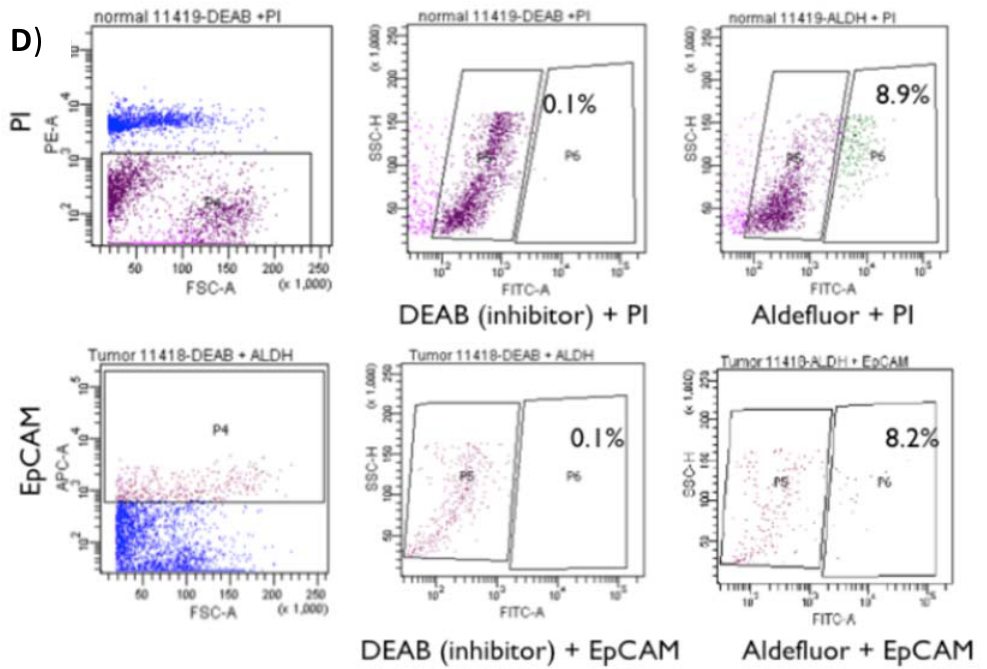
Figure 1. Identification and isolation of ALDEFLUOR-positive stem cells from fresh patient normal and tumor samples. Panels A, B—ALDH activity in the bottom of fresh normal isolated crypts. Normal isolated colonic crypts subjected to ALDEFLUOR assay in the presence ( A ) or absence of the inhibitor of ALDH activity ( B ). This image was taken using a Zeiss Epi-fluorescence microscope using the 10X objective. ( C ) Panel C shows ALDH activity in fresh dissociated patient tumor cells. Dissociated cells from fresh normal and tumor tissue show small populations of ALDEFLUOR positive (green) cells. Image was taken using a Zeiss Epi-fluorescence microscope using the 10X objective. ( D ) Panel D shows a histogram for flow cytometric isolation of stem cells from fresh patient normal and tumor samples. Gates showing representative percentages of isolated cells from fresh normal and tumor tissue positive for ALDH activity, when the DEAB control was set to 0.1%. Tumor cells were selected for EpCAM positivity (carcinoma cells) and normal cells negative for Propidium iodide (viable cells) for ALDEFLUOR assay and sorting.